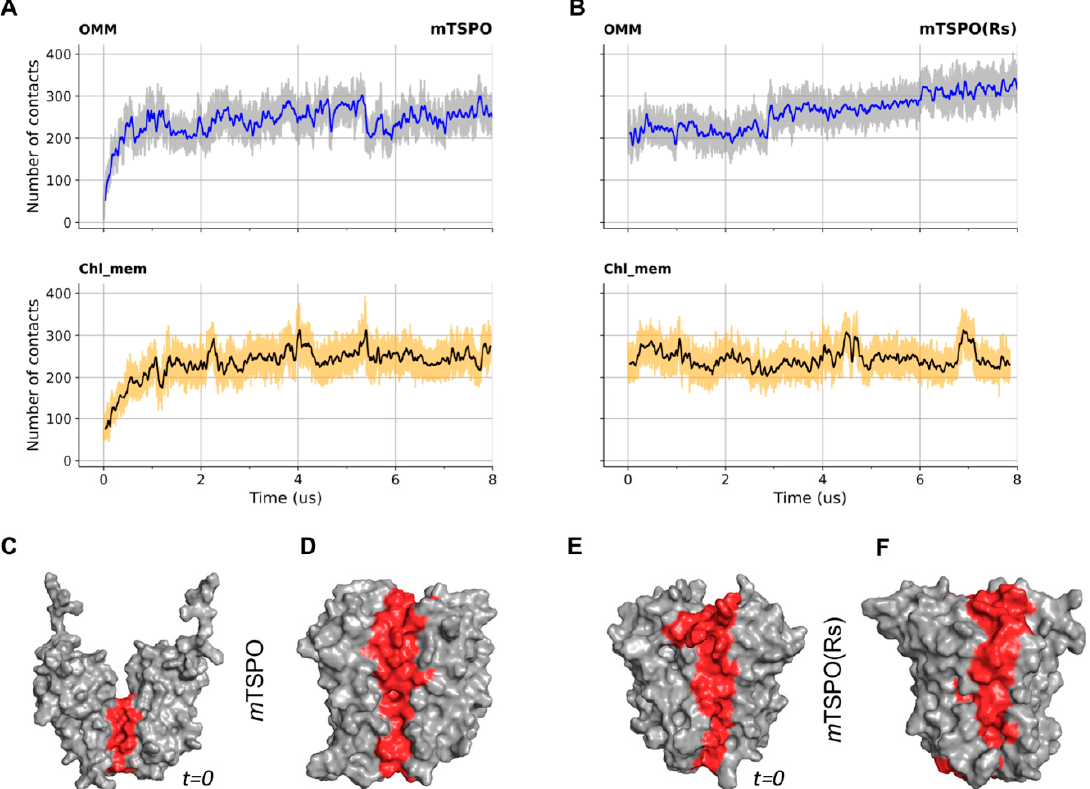
Figure 3. Number of monomer–monomer contact beads as a function of the simulation time in OMM and chl_mem for ( A ) m TSPO, ( B ) m TSPO(Rs). A cutoff of 0.6 nm was used. Surface representation of m TSPO structures before ( C ) and after ( D ) equilibration in OMM, as well as m TSPO(Rs) structures before ( E ) and after ( F ) equilibration in OMM, are shown. Their surface is represented in grey color, except for the residues in contact at the dimer interface which are highlighted in red.